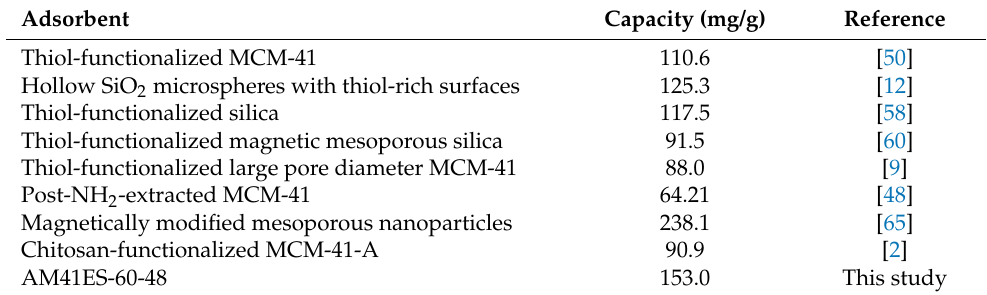
Table 11. Comparison of AM41ES-60-48 with other adsorbents in the removal capacity of